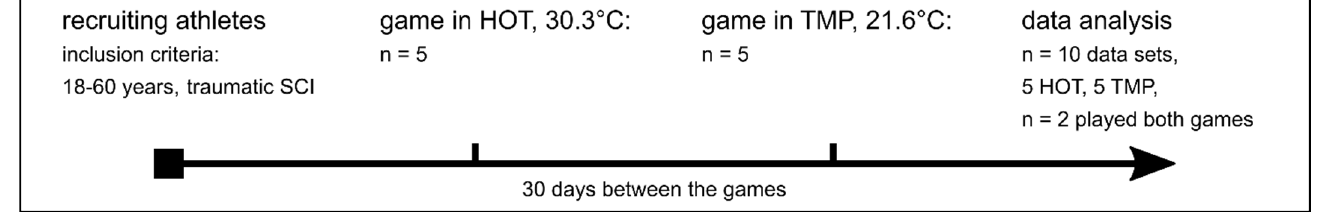
Figure 1. Study design, SCI = spinal cord injury, HOT = hot conditions, TMP = temperate conditions, n = number of participants.